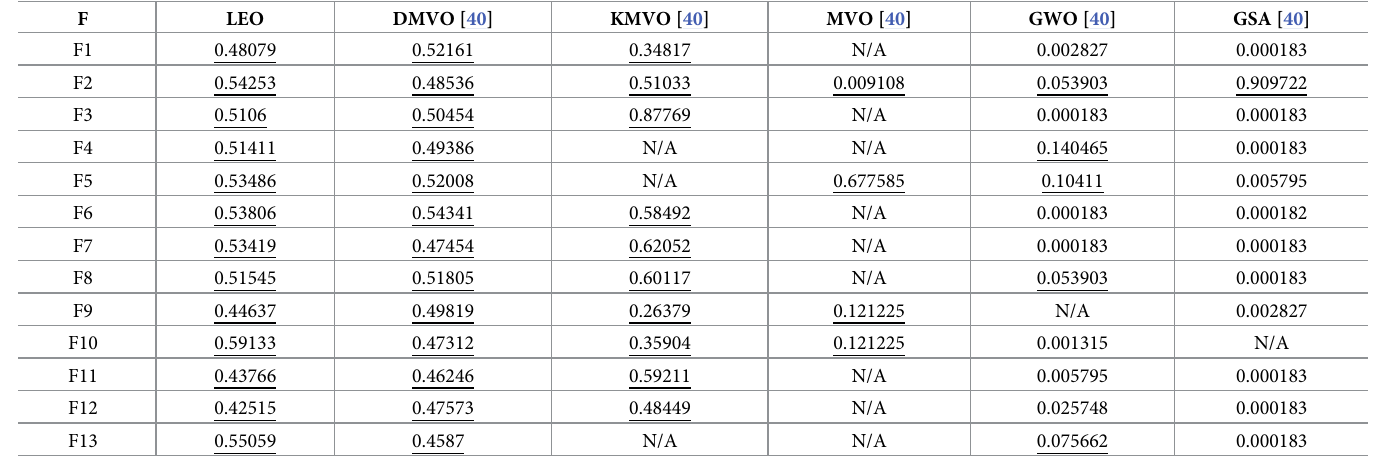
Table 5. P values of Wilcoxon rank sum test over 30